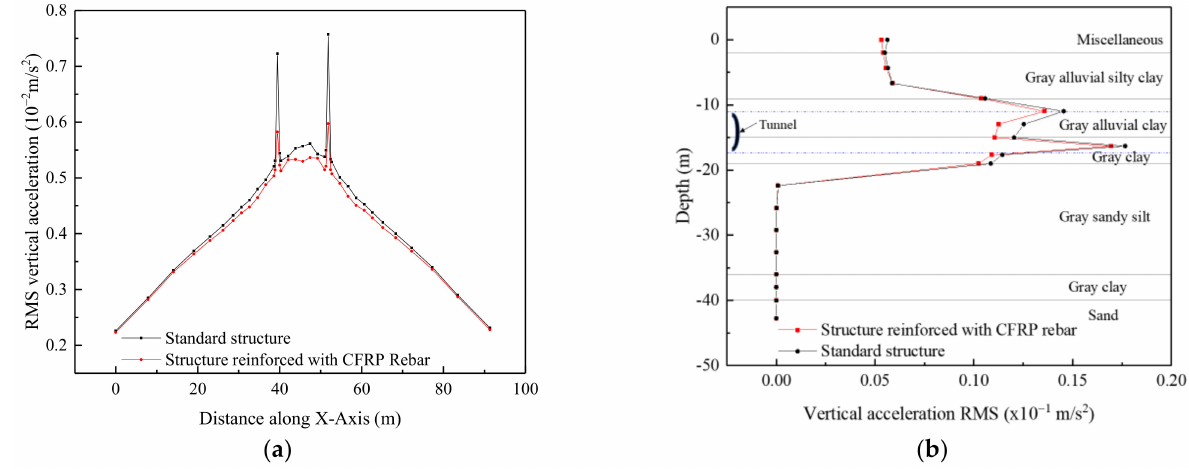
Figure 18. Vibration acceleration RMS. ( a ) Vibration RMS along model X-axis; ( b ) vibration RMS according to the